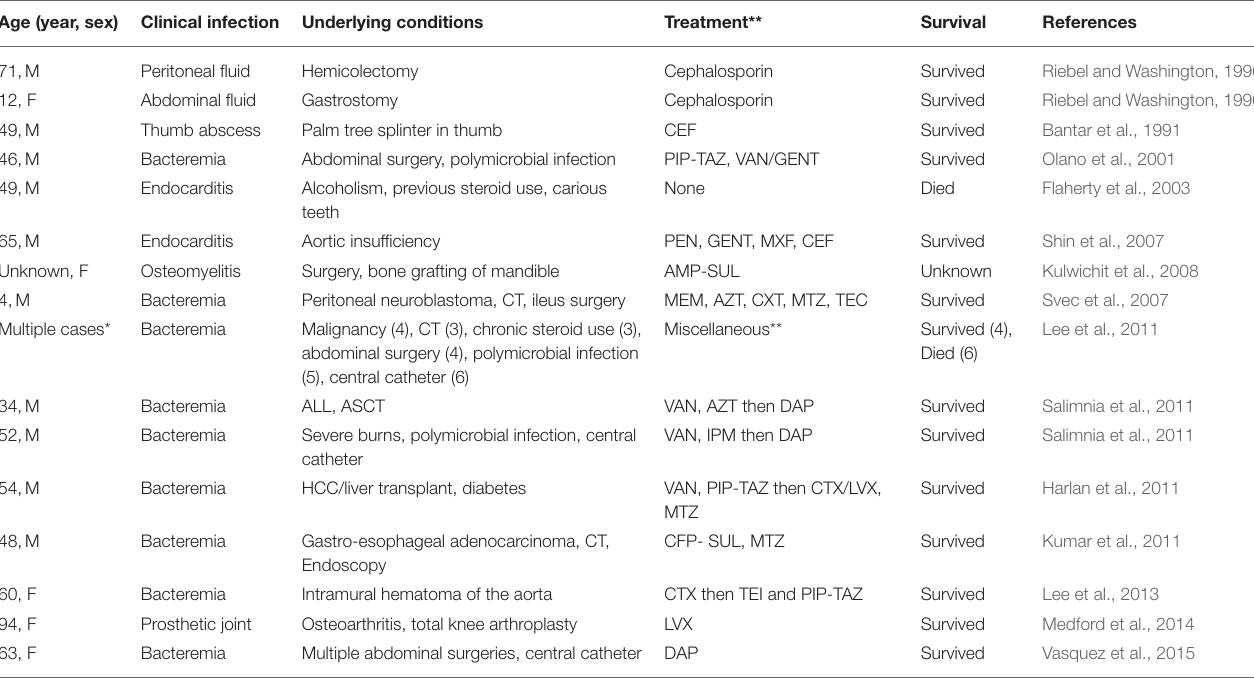
TABLE 1 | Summary of previously documented Weissella confusa